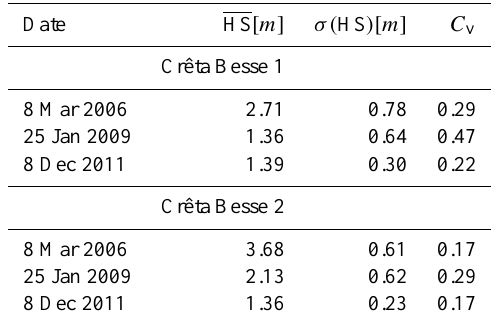
Table 2. Mean HS, standard deviation σ( HS ) and coefficient of variation C v of snow depth distribution for every laser scan acqui- sition in the CB1 and CB2